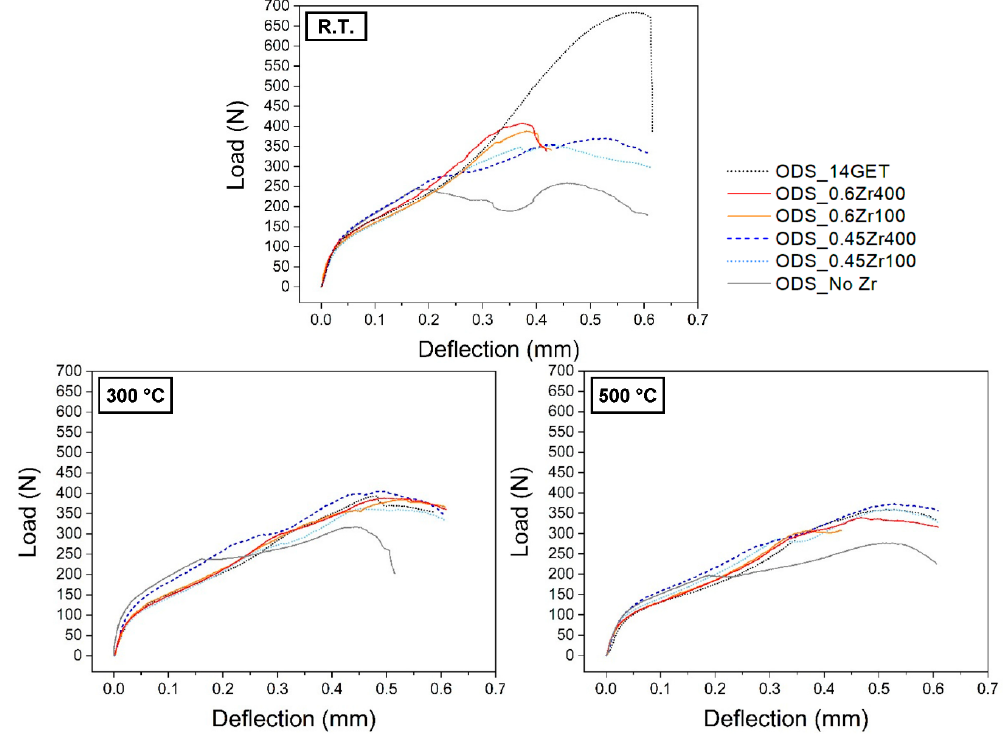
Figure 7. Load-deflection curves from small punch (SP) tests obtained at R.T., 300 and 500 °C for ODS sintered with different Zr contents and heating rates.